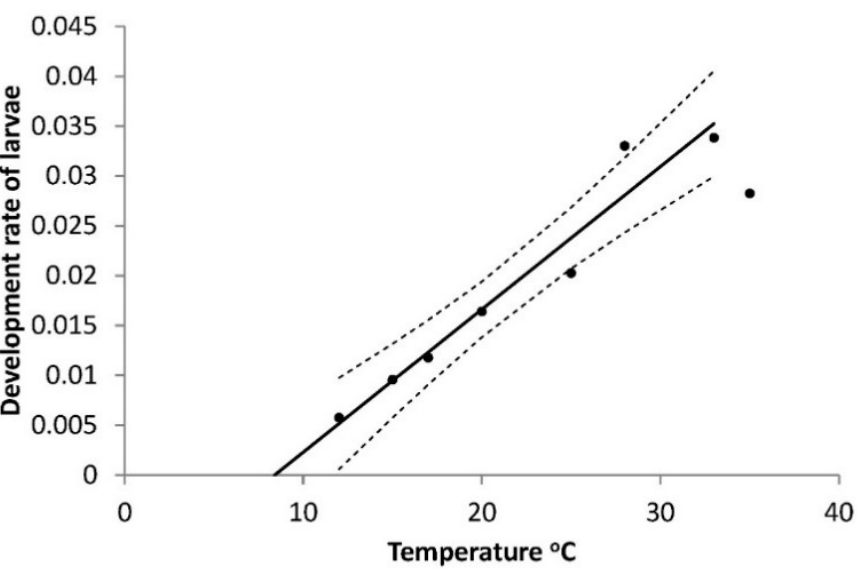
Figure 1. Temperature dependent development of all larval instars of Agrotis segetum at eight different temperatures; R larva = 0.0121 + 0.00144T (°C), R 2 = 0.906, p = 0.0001. The highest temperature, 35 °C, is not included in the calculated curve as this temperature appears to fall outsides the interval, which can justify straight line. The dashed lines above and below represent the upper and lower 95% confidence bands.